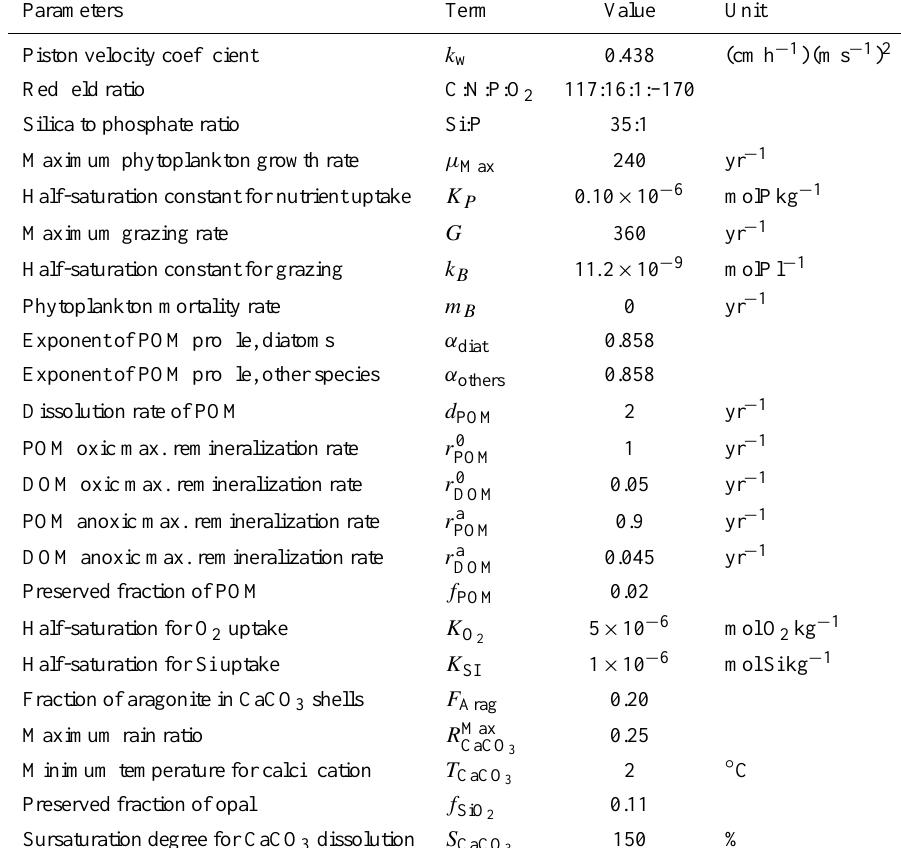
Table 4. Major parameters of LOCH. Parameters